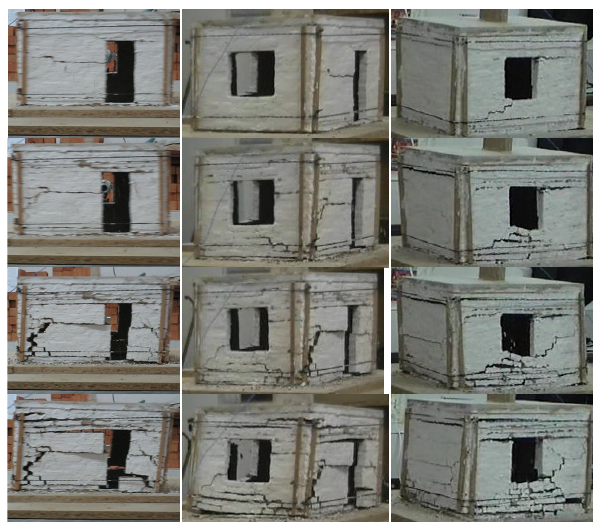
Fig. 23 Failure of specimen P1